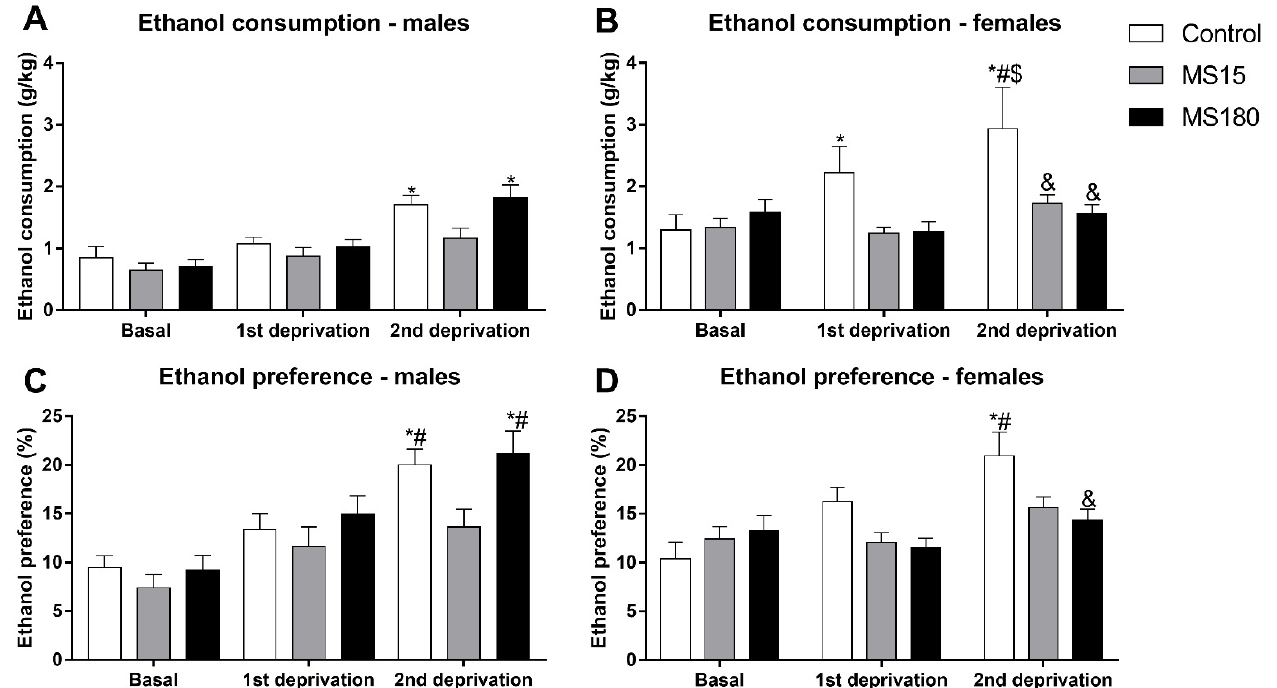
Figure 3. Alcohol deprivation effect (ADE) in female and male rats exposed to brief or prolonged maternal separation. The ADE was analyzed using the average ethanol intake or preference of four days after the end of each deprivation period compared to the last four days of the baseline period. The animals were submitted to two deprivation periods. Bars represent the mean ± SEM (n = 11–14 animals/group). ( A ), male ethanol consumption (g/kg); ( B ), female ethanol consumption (g/kg); ( C ), male ethanol preference; ( D ), female ethanol preference. *, p < 0.05 relative to the baseline ethanol consumption of the same gender control group; #, p < 0.05 relative to the ethanol consumption after the first deprivation of the same gender control group; &, p < 0.05 relative to the ethanol consumption after the second deprivation of the same gender control group; $, p < 0.05 relative to the ethanol consumption of the control male group after the second deprivation. MS15, brief maternal separation; MS180, prolonged maternal separation.